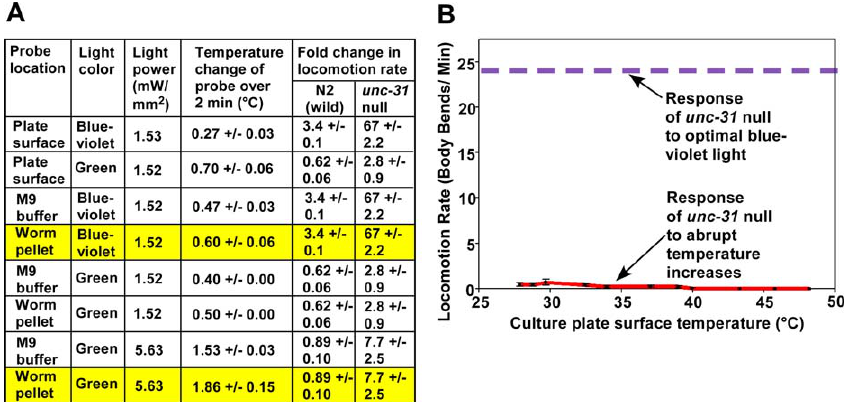
Figure 3. The Response to Light Is Not a Response to Temperature Changes Induced by the Light (A) The magnitude of the locomotory response to light does not correlate with light-induced temperature changes. We focused a light beam of the indicated color and power onto a metal temperature probe and noted the temperature change after 2 min of illumination. ‘‘ Plate surface ’’ means that the probe rested on the surface of the agar culture plate as we directly illuminated it. ‘‘ Worm pellet ’’ means the probe was inserted into a worm pellet of defined size and shape, consisting of living, assay-stage animals (see Materials and Methods). The worm pellet blocked direct light from reaching the probe, such that all heat effects are due to the light adsorption characteristics of the worms. Yellow highlighting indicates the essential data, which are the mean þ / (cid:2) standard error of three trials. All locomotion data for ‘‘ Fold change in locomotion rate ’’ are from Figure 2, except the data for N2 in green light. Note that ‘‘ Fold change ... ’’ values of , 1 indicate that the locomotion rate is lower than the locomotion rate in low white light. Errors for ‘‘ Fold change in locomotion rate ’’ are the standard errors of ten animals each. (B) Abruptly heating unc-31 nulls does not make them move. We transferred unc-31 nulls from a room temperature culture plate to a preheated culture plate and measured their locomotion rate in the first minute after transfer. Temperatures are an average of the plate surface temperatures at 30 and 90 s after transfer, which is the time period of the assay. Error bars are the standard errors of ten animals. Data for the response to optimal blue-violet light (dashed line) are from Figure 2.